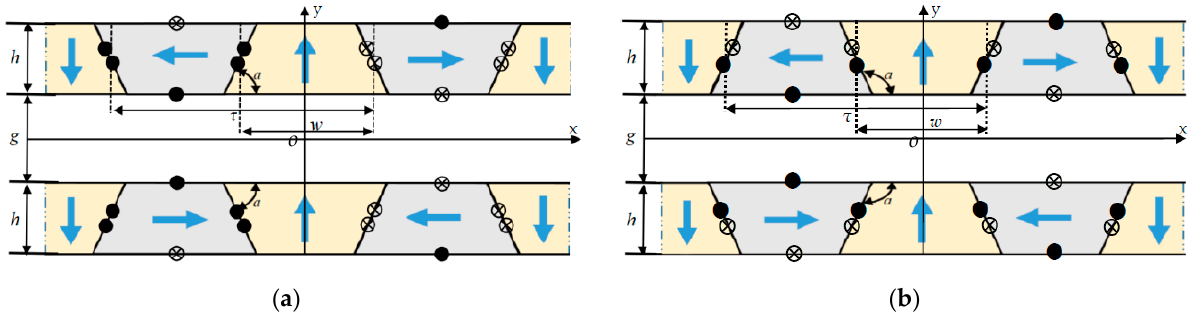
Figure 3. Analytical model of the modified equivalent surface current method for trapezoidal Halbach permanent magnet array: ( a ) 0 < α < 90 ◦ and ( b ) 90 ◦ < α < 180 ◦